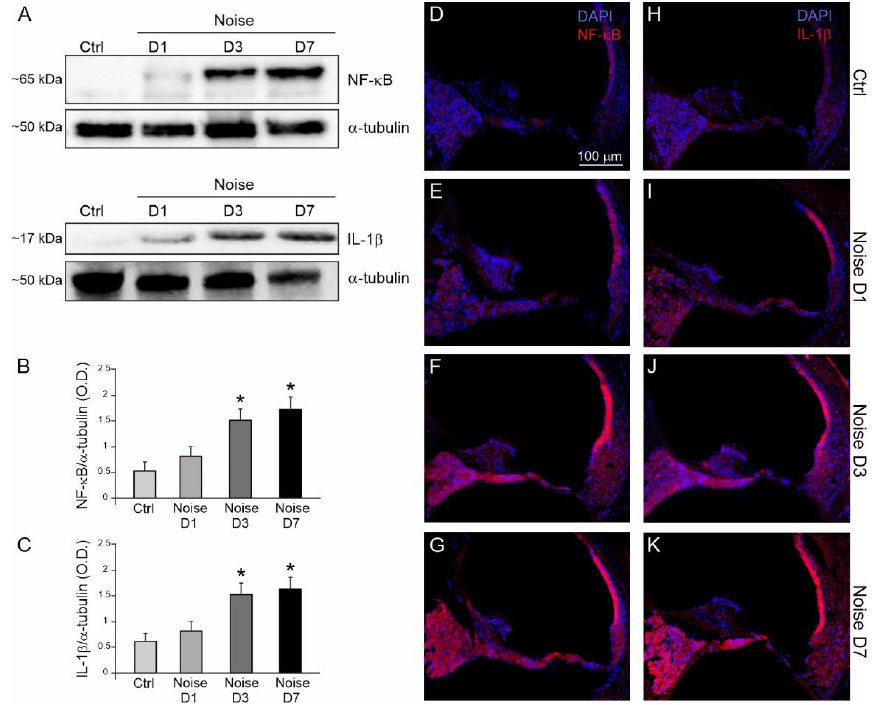
Figure 4. Increased cochlear inflammatory markers after noise exposure. ( A ): Western immunoblot- ting indicating NF-kB and IL-1β expression levels at 1, 3 and 7 days (D1, D3, D7) after noise exposure with respect to controls. ( B , C ): Histograms show the increase in the NF- κ B/ α -tubulin and IL-1 β / α - tubulin ratios after noise exposure (optical density, O.D.). Data are expressed as mean ± SEM from three independent experiments. Asterisks indicate significant differences between groups (* p < 0.05.